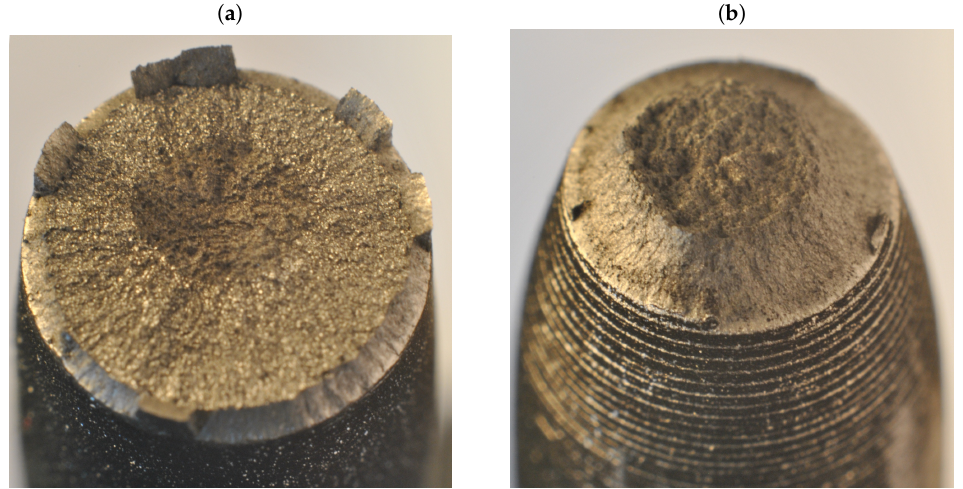
Figure 2. Fracture surfaces on 9mm-diameter specimens of two steels with different fracture patterns after testing under tension: ( a ) Material 1; ( b ) Material 2